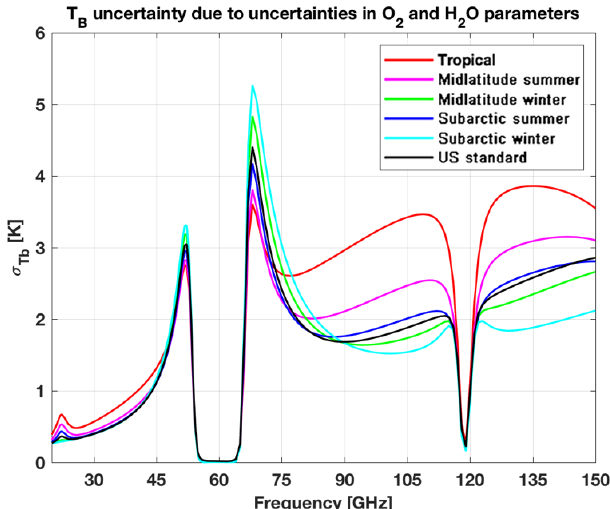
Figure 3. Time series of observed (lines) and simulated (markers) T B at 35.3 ◦ elevation for four channels of LWP-U72-82. The ra- diometer is located at the Polytechnic University campus in Mi- lan (Italy), while radiosondes used for the simulations are launched from the Milan Linate airport ( ∼ 20km from the Polytechnic Uni- versity campus). Channel frequencies are color-coded as reported in the legend. Simulations are reported with dots (23.84GHz), crosses (31.4GHz), triangles (72.5GHz), and circles (82.5GHz), including an indicative estimate of the total uncertainty. The cloud and rain flags are indicated at the bottom by blue and cyan crosses, respec- tively. The time series spans the period of 00:00 of 16 June (Julian day 167) to 00:00 of 19 June (Julian day 170)